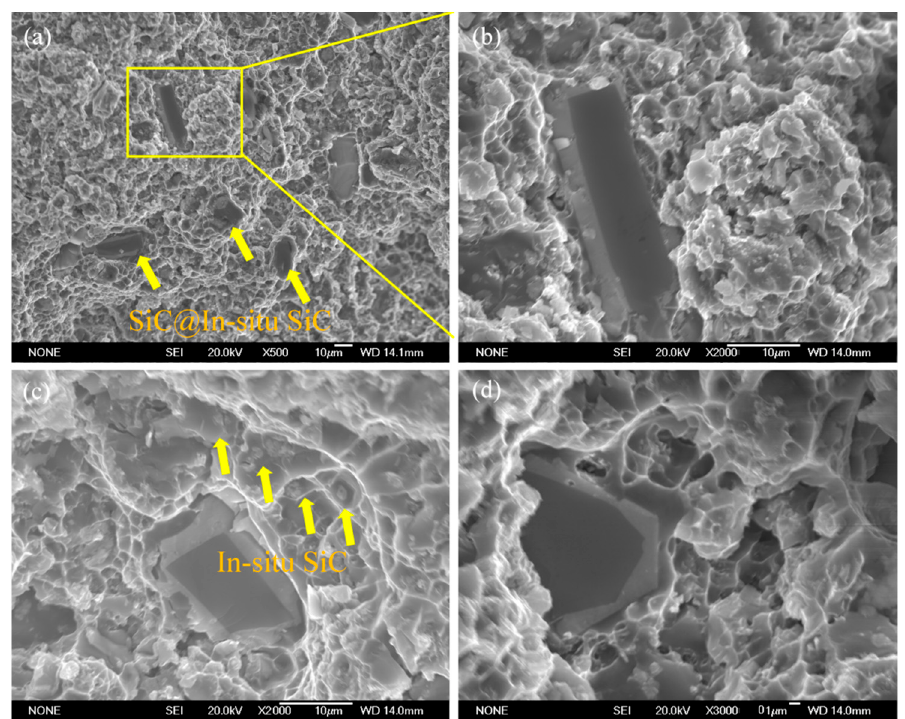
Figure 10. SEM images of the fracture of core-shell SiC (SiC@In situ SiC)-reinforced AMCs (Al-28Si-7C(G1)-5SiC): ( a ) SEM image of Al-28Si-7C(G1)-5SiC, ( b , c ) SEM images of Al-28Si-7C(G1)-5SiC, and ( d ) SEM image of Al-28Si-7C(G1)-5SiC.